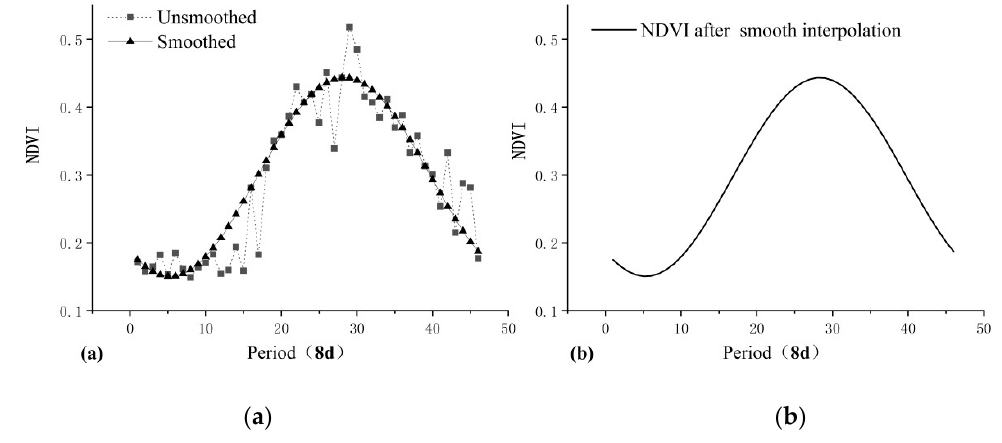
Figure 2. The previous NDVI time series data ( a ) and HANTS processing data ( b ).